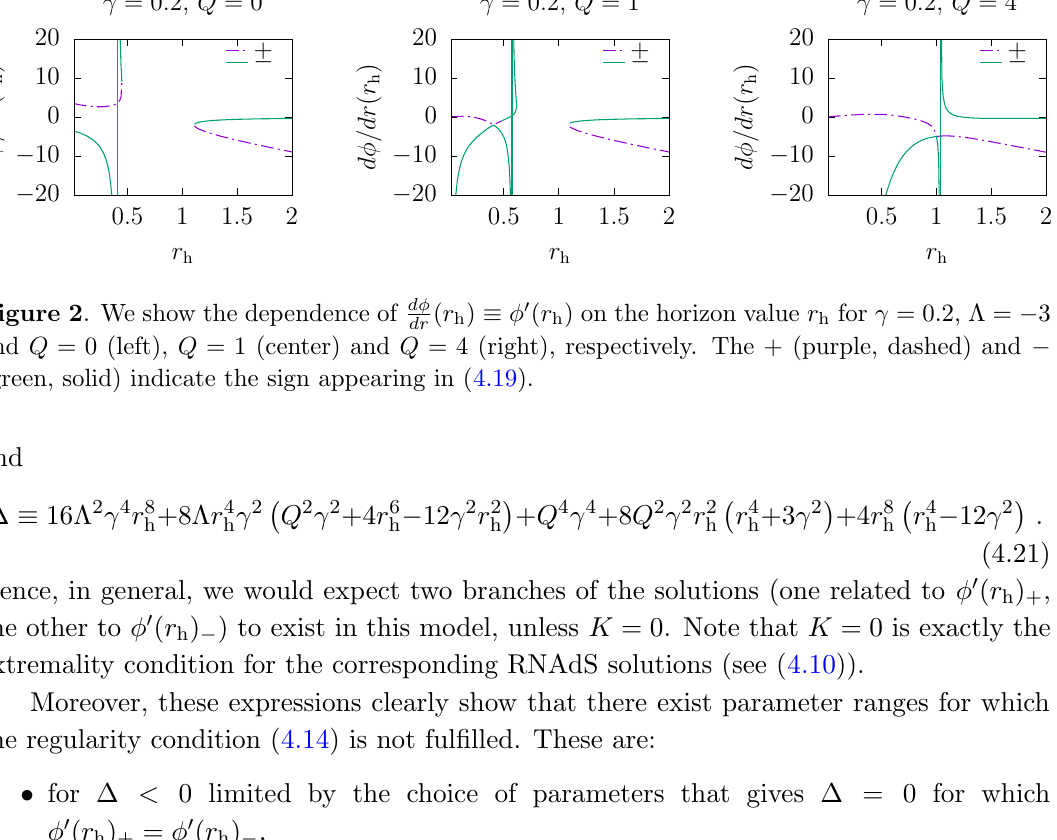
( r h ) (cid:30) 0 ( r h ) on the horizon value r h for (cid:13) = 0 : 2, (cid:3) = dr (cid:17)